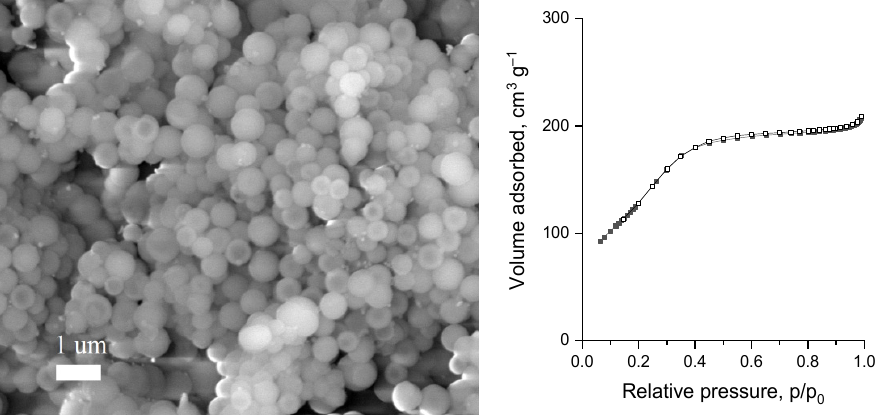
Figure 2. SEM image ( left ) and low temperature N 2 adsorption/desorption isotherm ( right ) of Ru/NS/3Mg/NS.